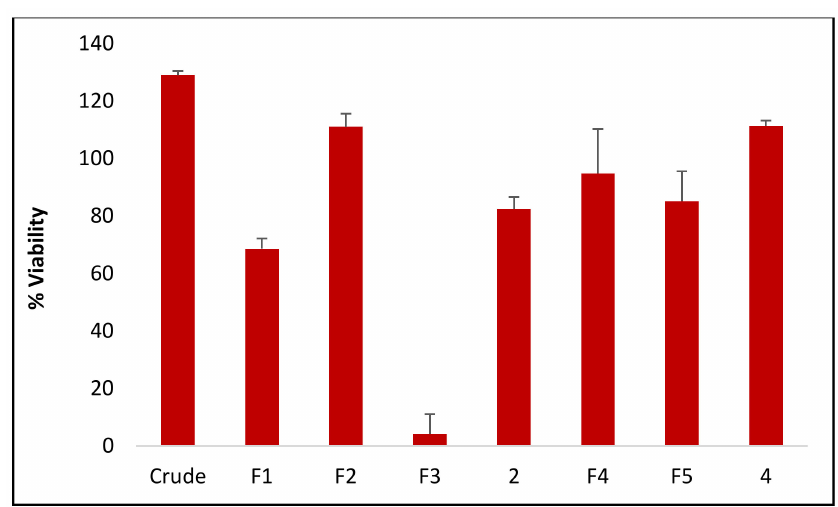
Figure 2. Antimalarial activity of crude, fractions, raucaffricine ( 2 ) and spegatrine ( 4 ) expressed as % parasite viability ± SD.